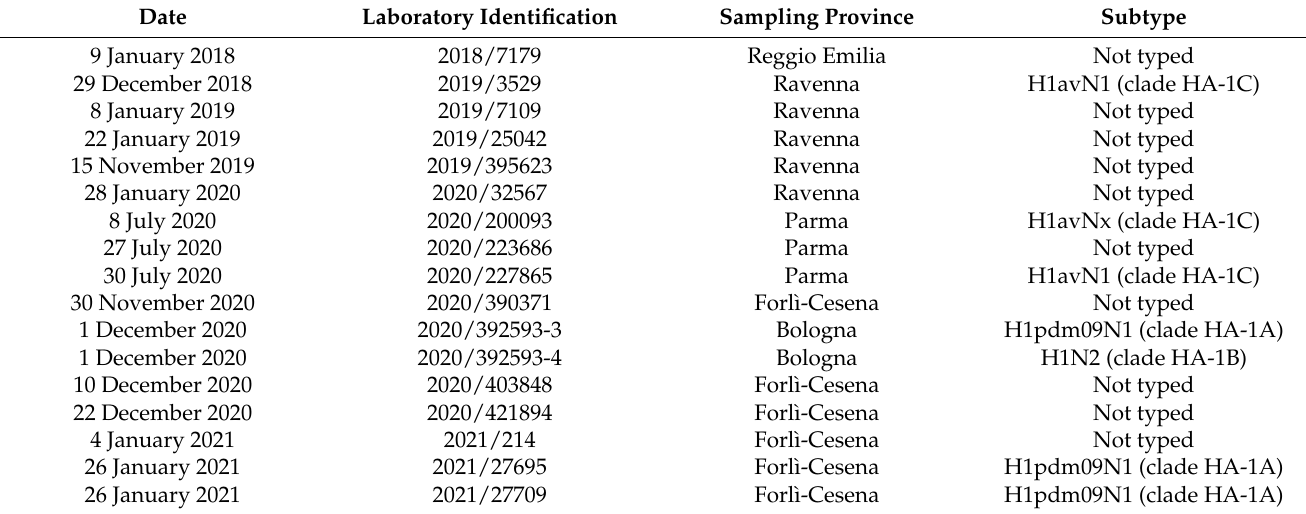
Table 1. SwIAV-positive samples subtyped during the